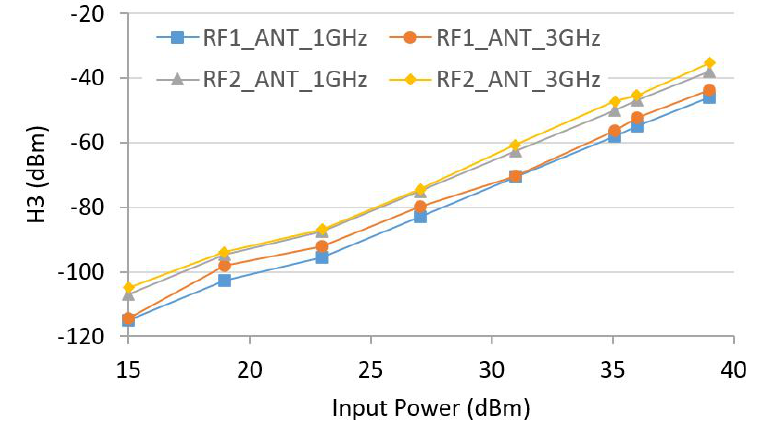
Figure 19. Measured 3rd harmonics of the SPDT switch. Table 3. Performance comparison with published